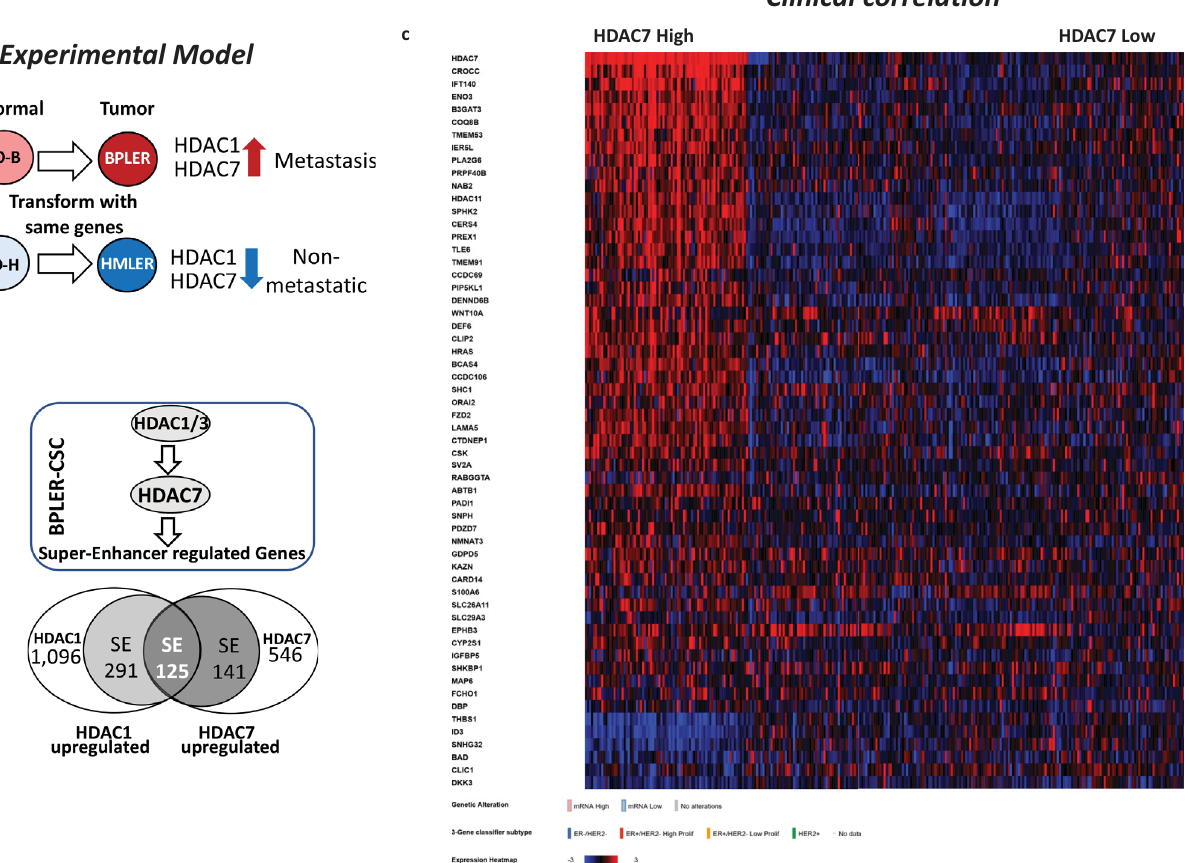
Fig. 1 Identi fi cation of a cell-of-origin signature. a Two different cell-of-origins, CO-B (BPEC) and CO-H (HMEC), were isolated from the normal breast of the same donor and transformed using identical genetic elements 20 . Transformation of CO-B give rise to tumorigenic BPLER cells with high HDAC1 and HDAC7 expression. Transformation of CO-H give rise to HMLER cells with low HDAC1 and HDAC7 expression 4 . When implanted into immunocompromised mice orthotopically, BPLER cells generate invasive and metastatic xenograft tumors. In contrast, patient matched isogenic HMLER cells form indolent non-metastatic tumors 20 . b HDAC1/3 upregulates HDAC7, which in turn upregulates 266 super-enhancer (SE) associated genes in BPLER cells, 125 of these genes are also upregulated by HDAC1 5 . c The expression heatmap of 63 HDAC1/7-SE target genes that have a statistically signi fi cant correlation with HDAC7 expression in human tumors (see Supplementary Table 2 for more details). The heatmap shows that the vast majority of these genes (56/63) are over-expressed in human breast cancers with high a HDAC7 expression, consistent with the in vitro results from BPLER cells. The remaining 7 genes have an inverse correlation with HDAC7 in vivo, diverging from the in vitro results. Red = high expression, blue = low expression, (see Supplementary Fig. 1 for a high resolution of the heatmap). HDAC7 co-expression and heatmap is generated using cBioPortal online tools by analyzing METABRIC data set with complete samples ( n = 1904) 58,59 , and mRNA expression z -scores relative to diploid samples 57